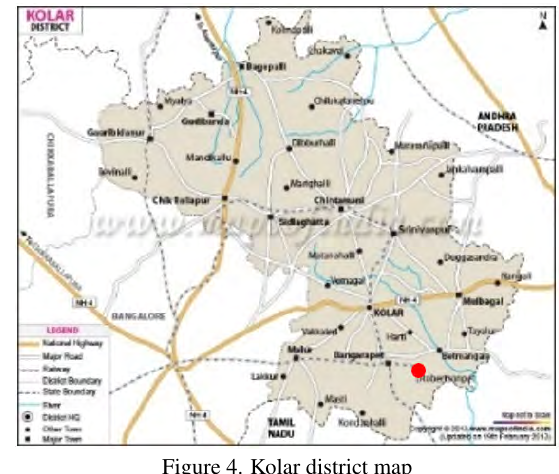
Figure 4. Kolar district map